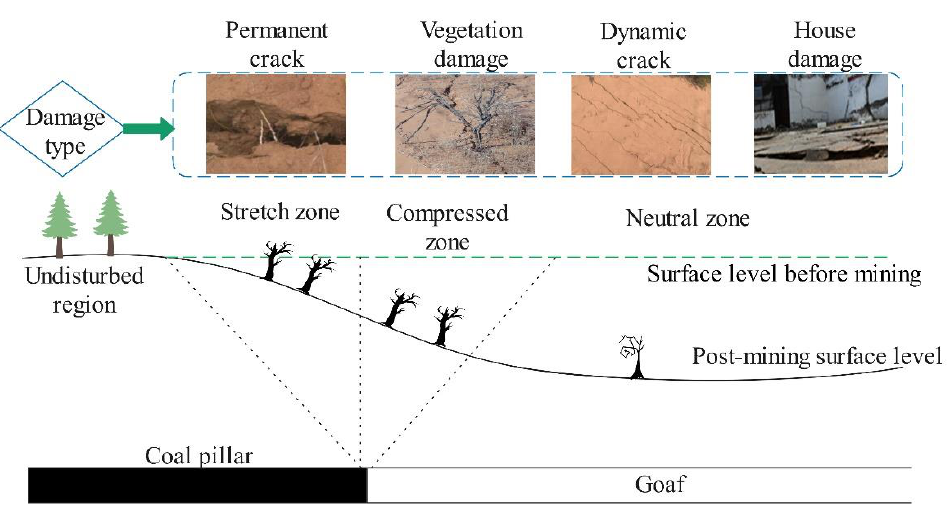
Figure 1. Surface damage type.